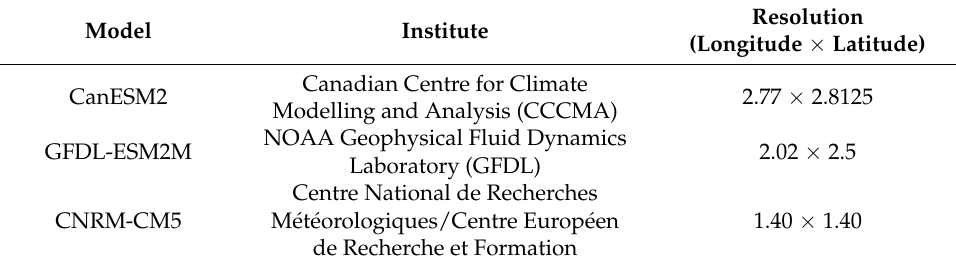
Figure 2. Area under study, situated in the east of Iran. Table 1. Summary of CMIP5 climate models used in this